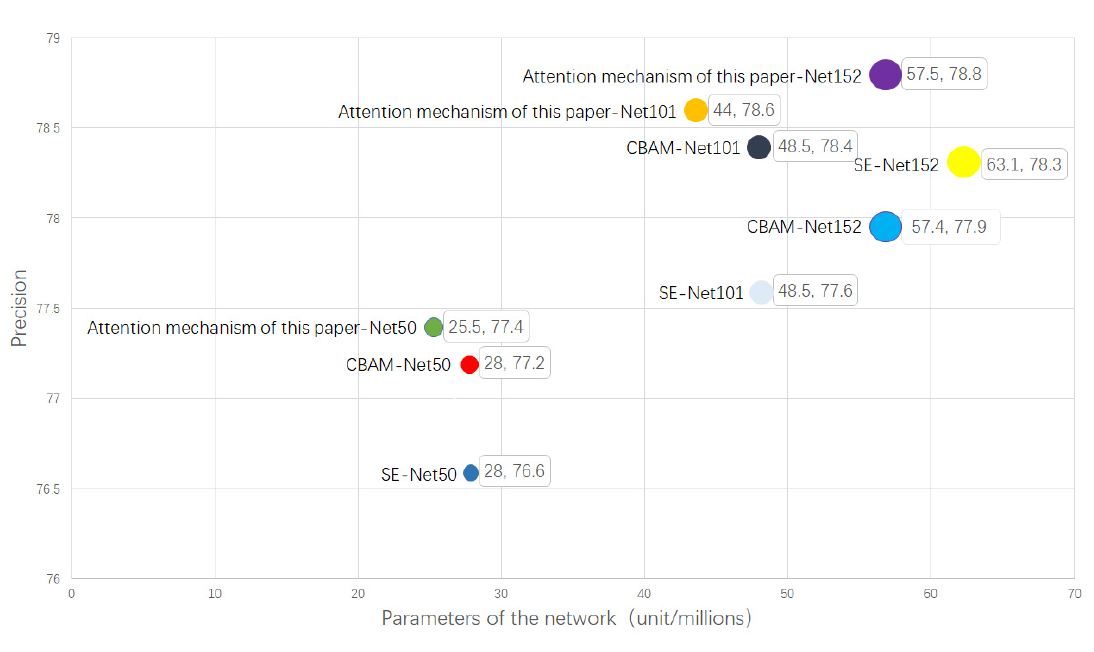
Figure 4. The contrast of attention mechanisms.